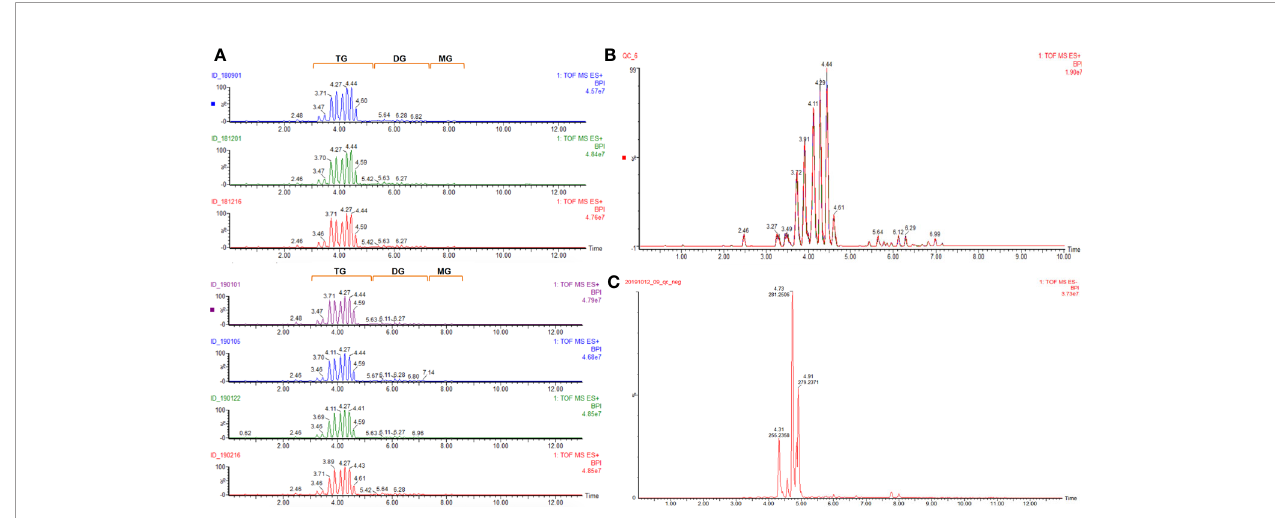
FIGURE 1 | Total ion chromatogram of (A) (qualitative analysis of glyceride contents of seven batches of coicis semen oils in ESI + ); (B) (overlay of the QC sample for the differential component analysis of different samples in ESI + ); (C) (qualitative analysis of free fatty acids of QC sample in ESI −